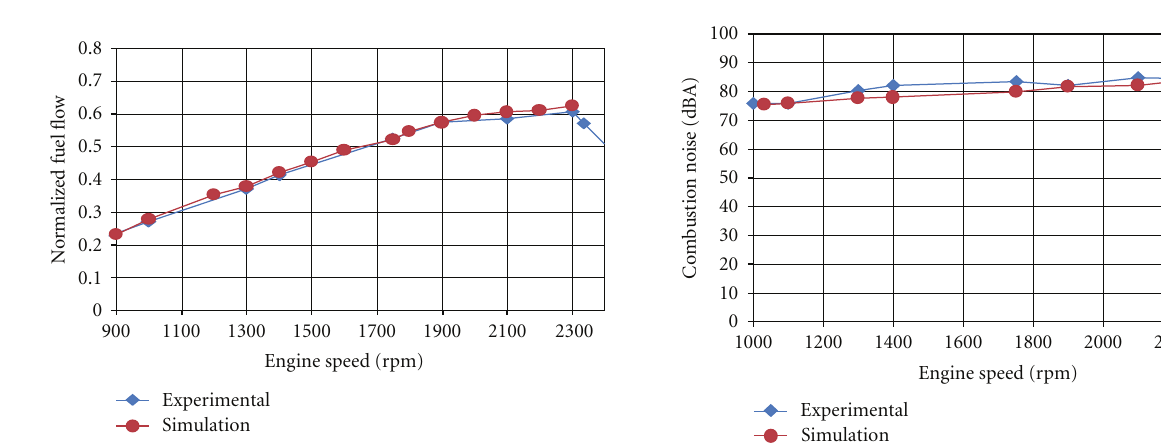
Figure 10: Comparison of experimental and simulated values of combustion